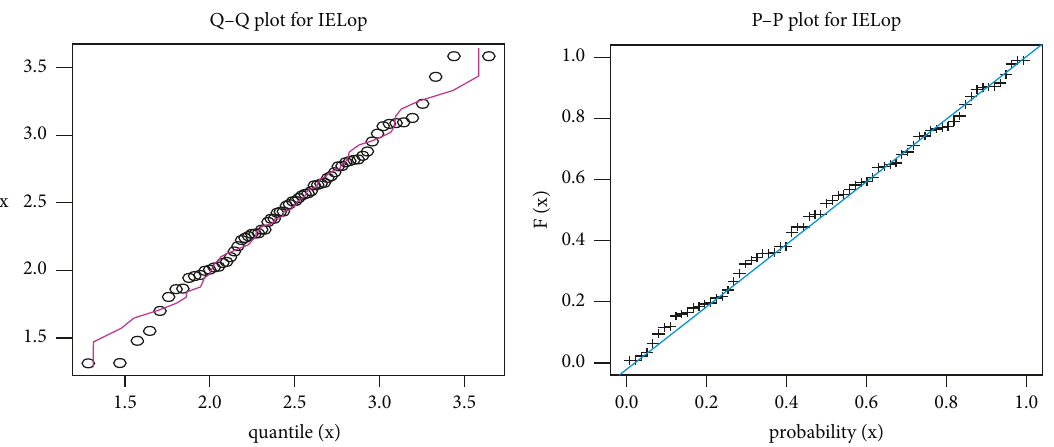
Figure 7: P-P plot and Q-Q plot for IELoP distribution for dataset II. Table 10: Estimation methods for IELoP distribution for dataset I.